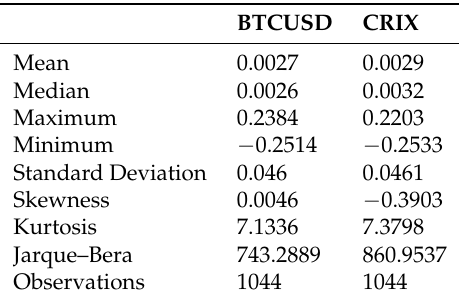
Table 2. Descriptive statistics (Log-returns).